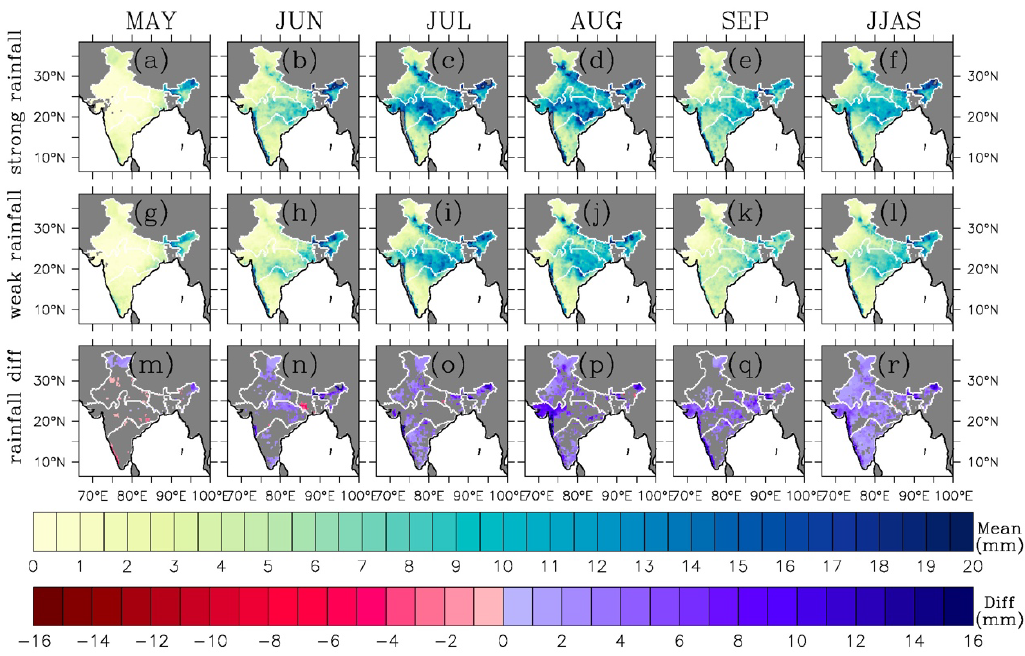
Figure 3. Spatial variations in monthly mean rainfall for May through September and JJAS-mean rainfall for strong ISMs ( top row , ( a – f )), weak ISMs ( second row , ( g – l )), and its difference (strong ISMs minus weak ISMs) ( bottom row , ( m – r )). The difference is shown only when it is statistically significant at a 95% confidence level. The monthly and JJAS-mean rainfall was computed based on the IMD 0.25° daily gridded rainfall. The horizontal color bar on the top and bottom denotes the mean and difference, respectively. The unit for daily rainfall is mm. The borders between the IMD regions are shown in white.